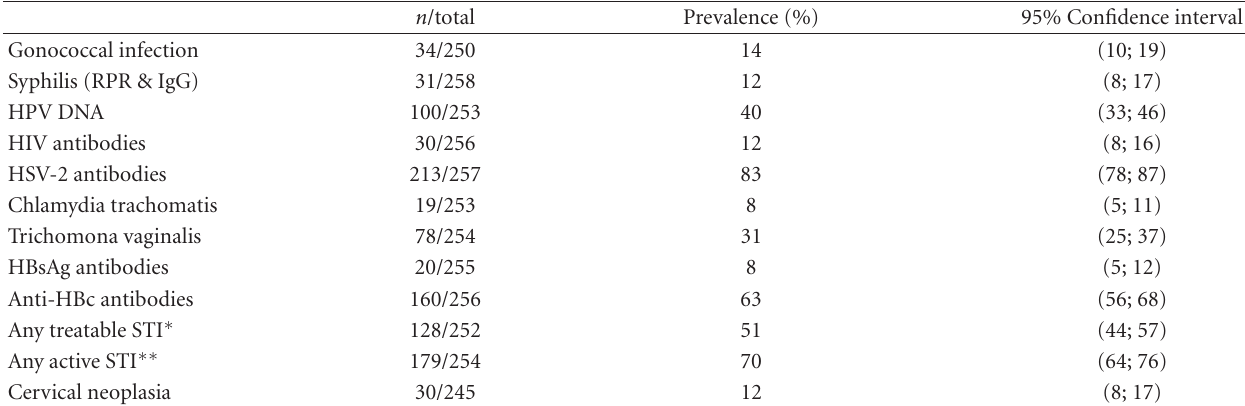
Table 2: Prevalence of STIs and cervical neoplasia in women from Manhic¸a,